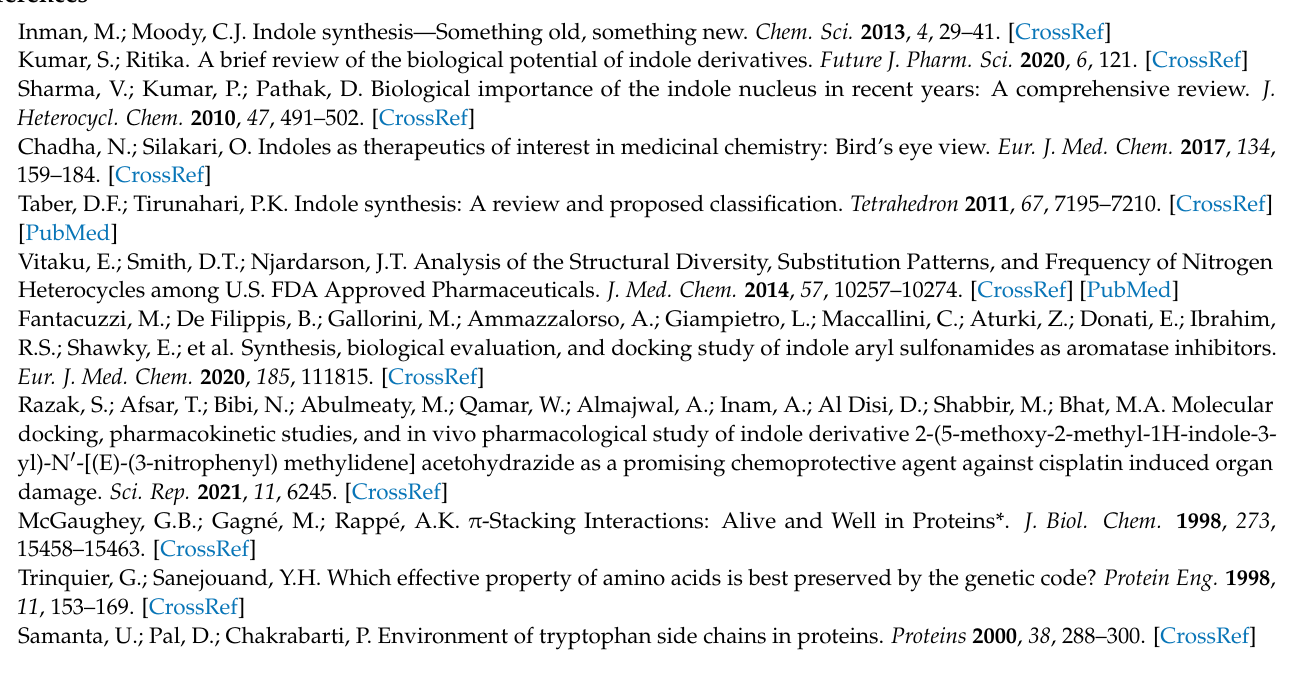
Table S8: coordinates of 3-methylindole monomers; Table S9: Coordinates of 3-methylindole dimers; Table S10: Coordinates of toluene